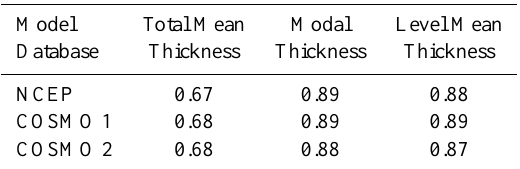
Table 3. Linear correlation coefficients between observed mean/modal/level thickness and modeled thermodynamic thick-